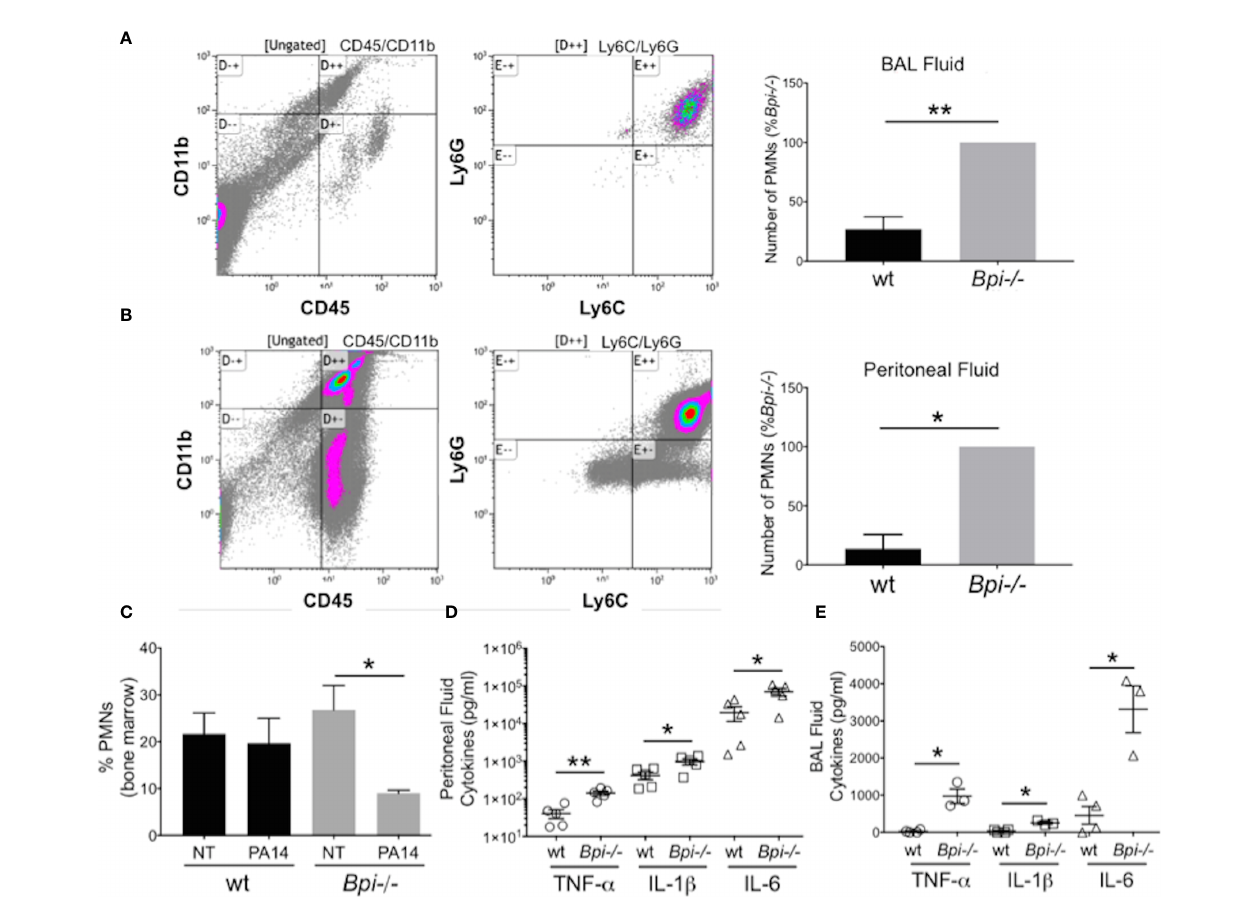
FIGURE 2 | Increased neutrophil recruitment and in fl ammatory cytokines were observed at infected sites in BPI-de fi cient mice. (A, B) Neutrophil numbers in the (A) bronchoalveolar lavage and (B) peritoneal lavage of mice infected for 3h with PA14 3x10 6 CFU) were determined by fl ow cytometry (CD45 + CD11b + Ly6G + Ly6C + ). Bar graphs represent number of neutrophils (PMNs) recovered from wt and Bpi-/- mice (n=4). Cell count was calculated from % neutrophils from fl ow cytometry and total number of peritoneal or BAL cells. Representative fl ow panels from Bpi-/- mice showed the majority of BAL (A, 97.3%) and peritoneal (B, 90%) immune cells are neutrophils. (C) Percent bone marrow neutrophils in untreated wt and Bpi -/- mice (n=4) as well as following oropharyngeal infection (PA14, 3x10 6 CFU, 3hpi). (D, E) In fl ammatory cytokines TNF, IL-1b, and IL-6 (pg/ml) were measured in (D) peritoneal fl uid (n=5) and (E) BAL (n=3,4) of mice infected with PA14 (3x10 6 CFU, 3hpi). All data were analyzed by unpaired t-test with Welch ’ s correction, except for data in (C) which were analyzed by paired Student t-test, **p < 0.01, *p < 0.05; Error bars represent mean ±